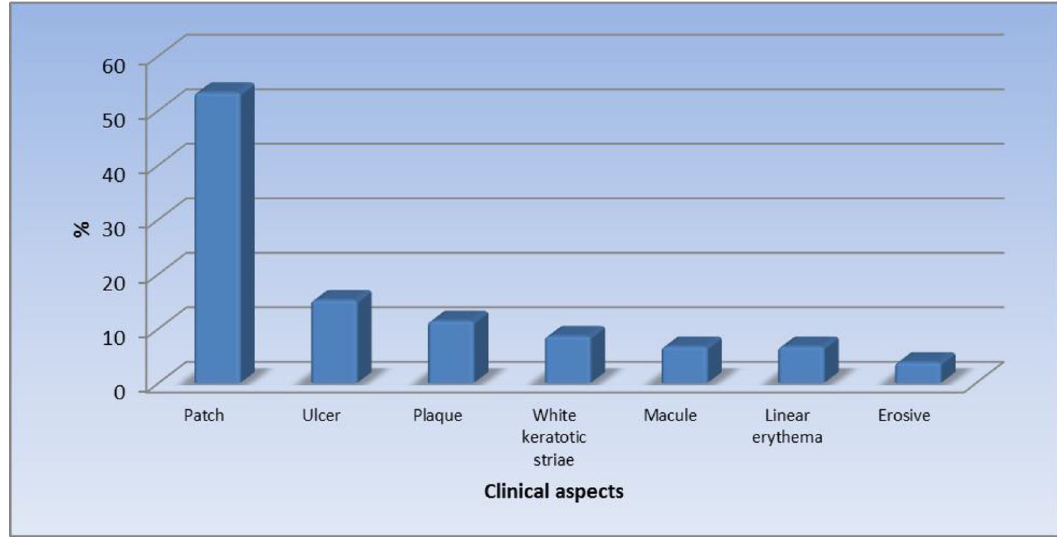
Figure 2. Clinical aspects of the oral lesions (n =